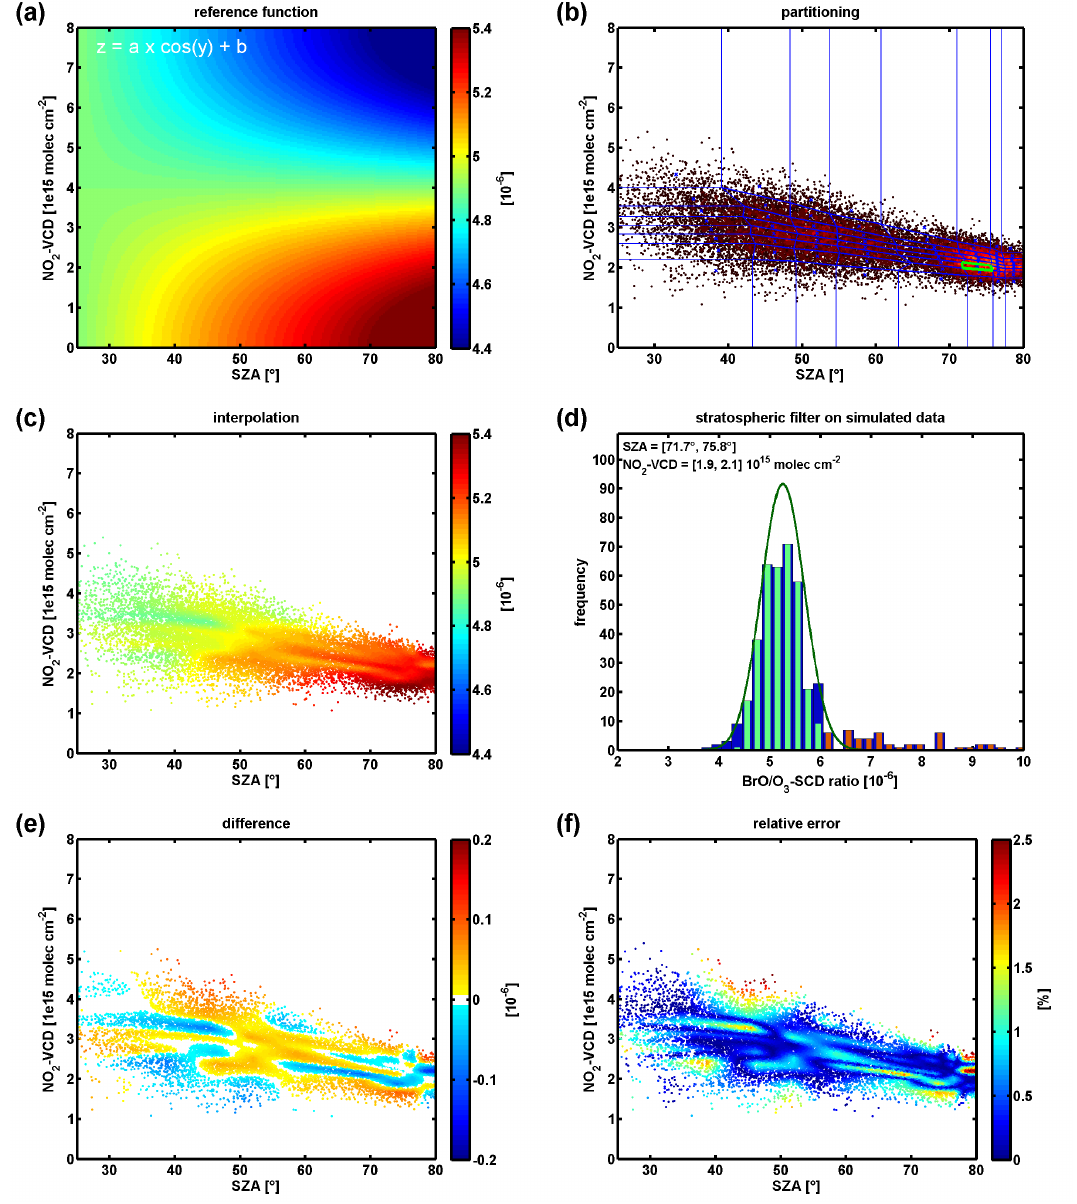
Fig. 9. Benchmark of the separation algorithm (Sect. 2.2 and Appendix A) using simulated measurements modelling a (a) known surface. (b) Partitioning of measurements, (c) interpolated surface nodes, (d) application of asymmetry filter. (e) The difference between true and retrieved surface function shows only small deviations. (f) The relative error almost never exceeds